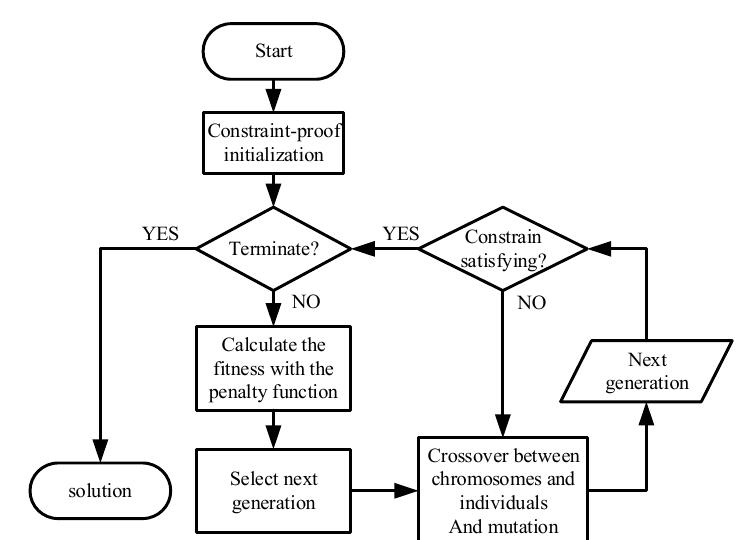
Figure 3. Procedure for the Improved Genetic Algorithm (IGA).